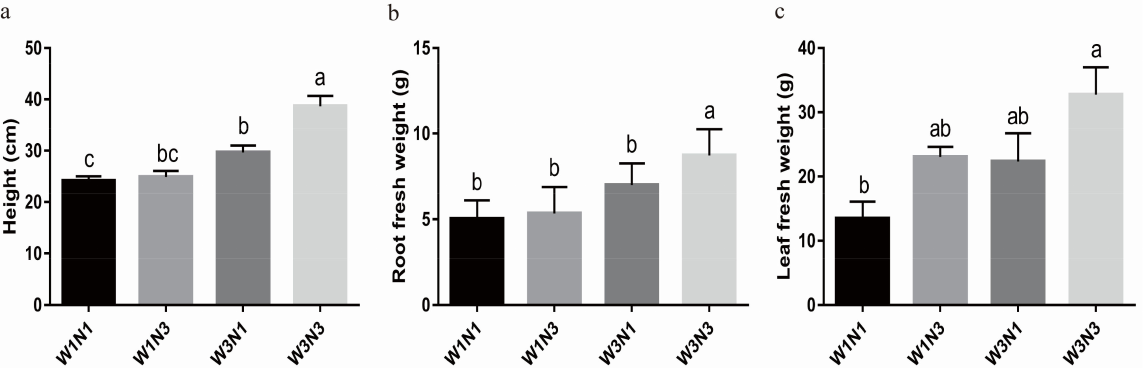
Figure 2. Plant growth indexes under varied water and nitrogen treatments. ( a ) Plant height of each treatment group. ( b , c ) Root fresh weight ( b ) and leaf fresh weight ( c ) of each treatment group. Values on bar are mean ± standard error ( n = 9). Different letters indicate significant differences ( p <